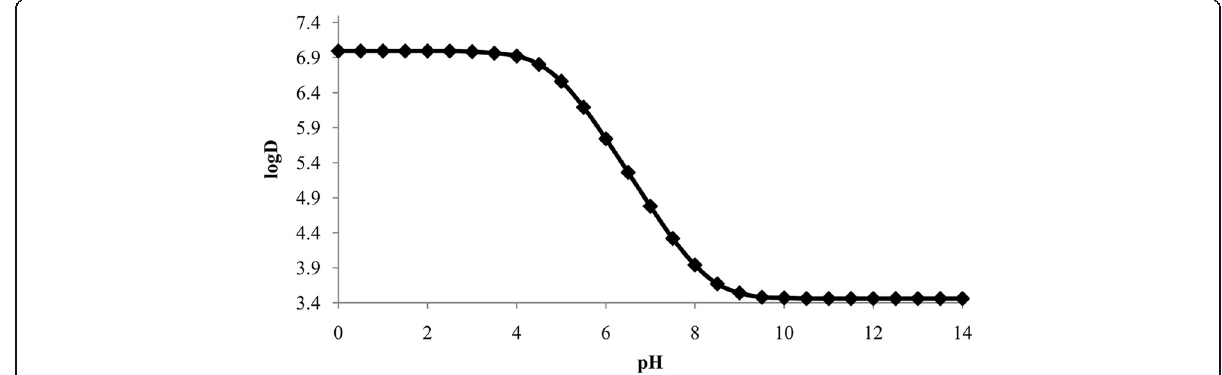
Fig. 6 Distribution coefficient (logD) of betulinic acid over the pH range of 0.0 to 14.0